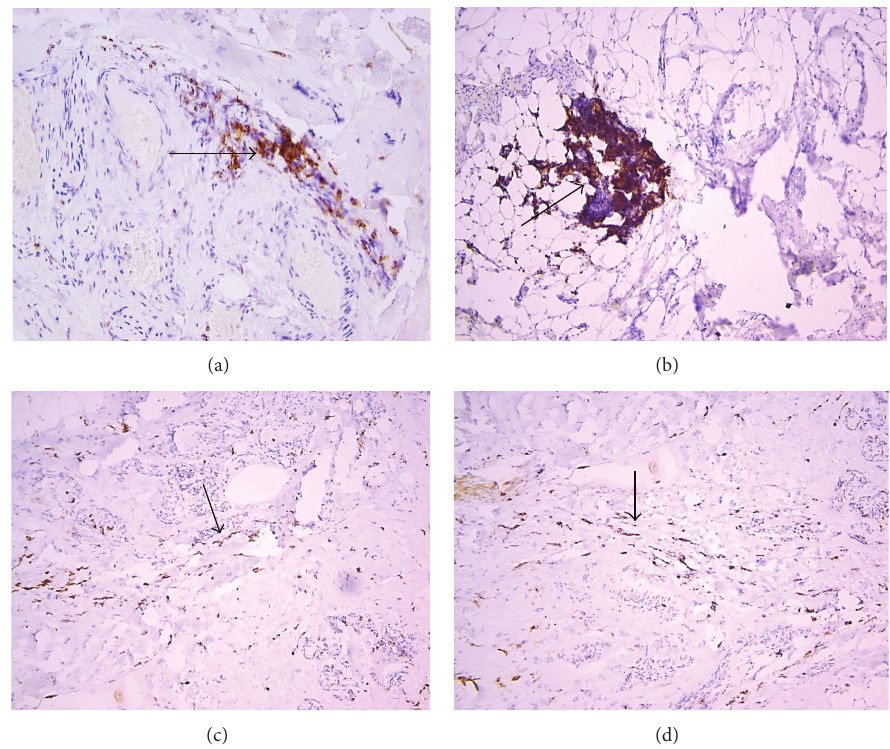
Figure 3: Immunohistochemistry with DAB staining. (a) The arrow head presents the focal cluster of T lymphocyte (CD4+) brown cytoplasmatic staining in the mild type of GO. Magn. 200x. (b) The arrow head shows the cluster of T lymphocytes (CD4+) brown staining in the severe type of GO. Magn. 100x. (c) and (d) The arrow head presents significant fibroblasts and macrophages clusters (CD68+) brown cytoplasmatic staining observed in the fibrous connective area of the adipose tissue of the mild GO (robust 3c) and severe one (d). Magn. 100x.